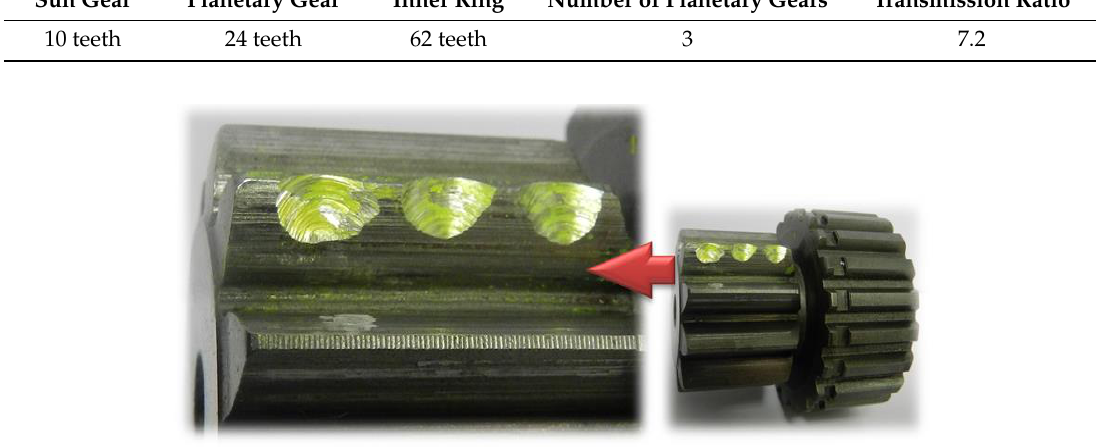
Figure 6. The planetary gearbox experiment system. Table 3. Configuration parameters of the planetary gearbox.